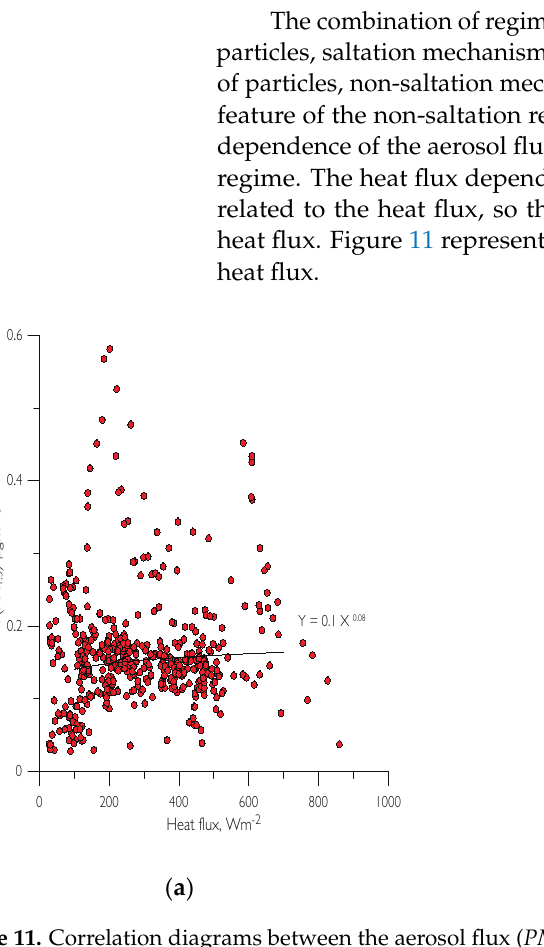
Figure 11. Correlation diagrams between the aerosol flux ( PM 1.5 ) and the sensible heat flux ( 𝐹 heat ). Daytime: 10:00–20:00: ( a ) Convectional entrainment of particles, non-saltation mechanism prevails for 24 July 2009; ( b ) Wind entrainment of particles, saltation mechanism prevails for 28 July 2011.